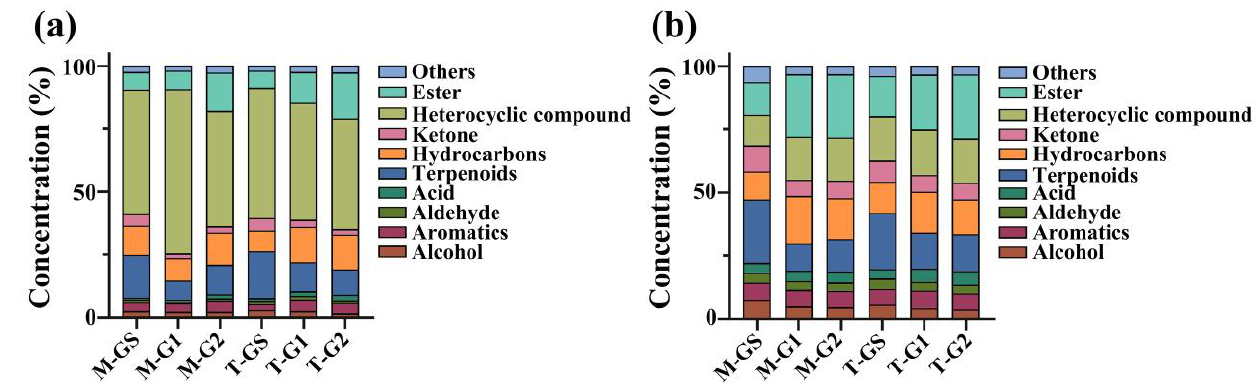
Figure 2. Comparison of total volatile components between Shandong matcha and tencha. ( a ) HS-SPME. ( b ) SAFE.